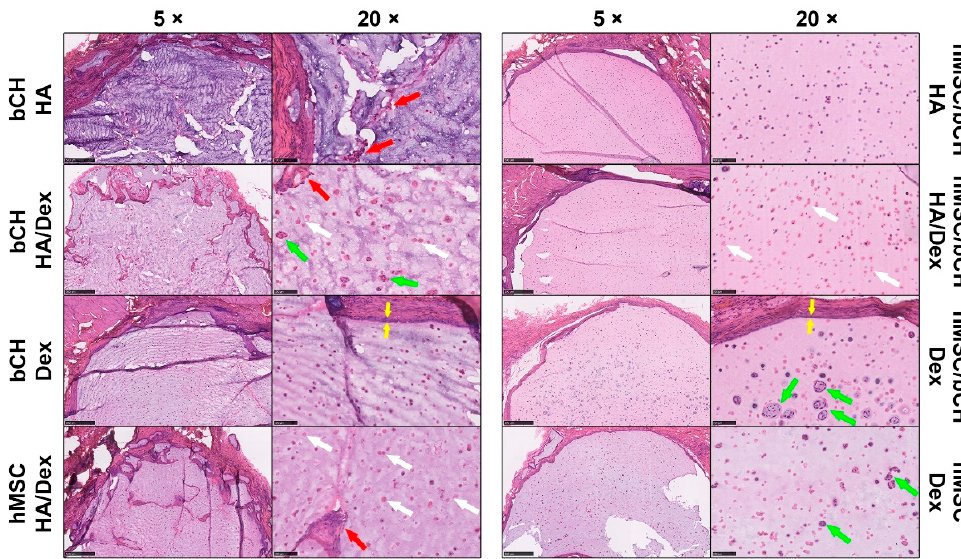
Figure 2. Histological analysis of in vivo response after 28 days of subcutaneous implantation. Representative histological sections of hydrogel samples stained with H&E. The left panel in each condition shows 5 × magnification pictures (scale bars represent 500 μ m), whereas the right panel shows 20 × (scale bars represent 100 μ m). The red arrows in the stained sections show giant cells, the green arrows show cell clusters, and the white arrows show the cells without visible nuclei, respectively. Yellow arrows at the material/tissue interface indicate a layer of inflammatory cells.